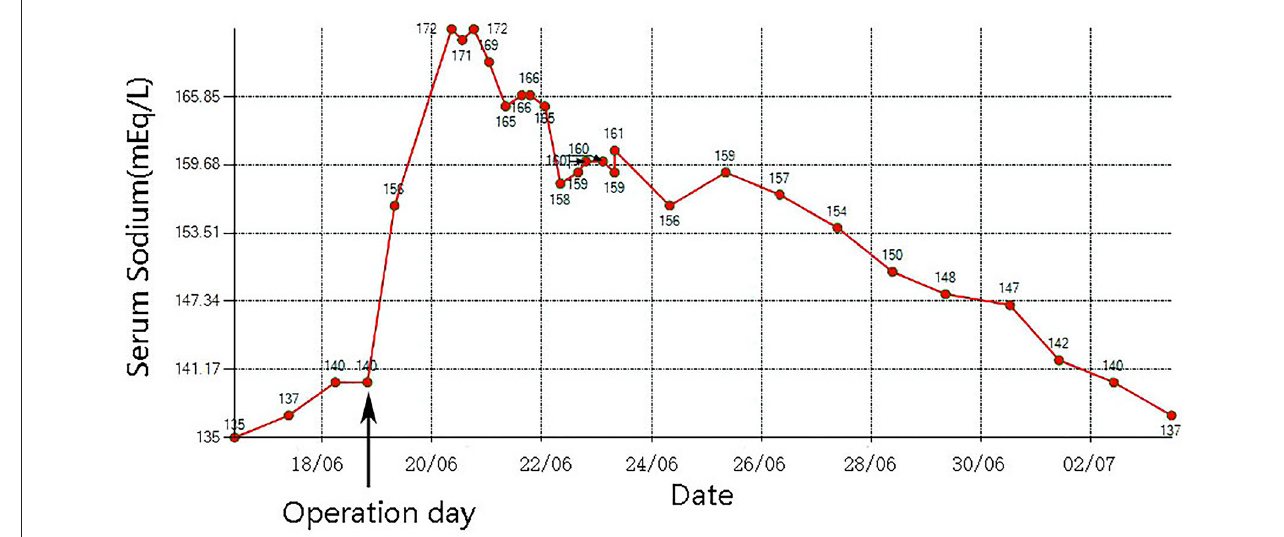
FIGURE 2 | The change of serum sodium in this case.